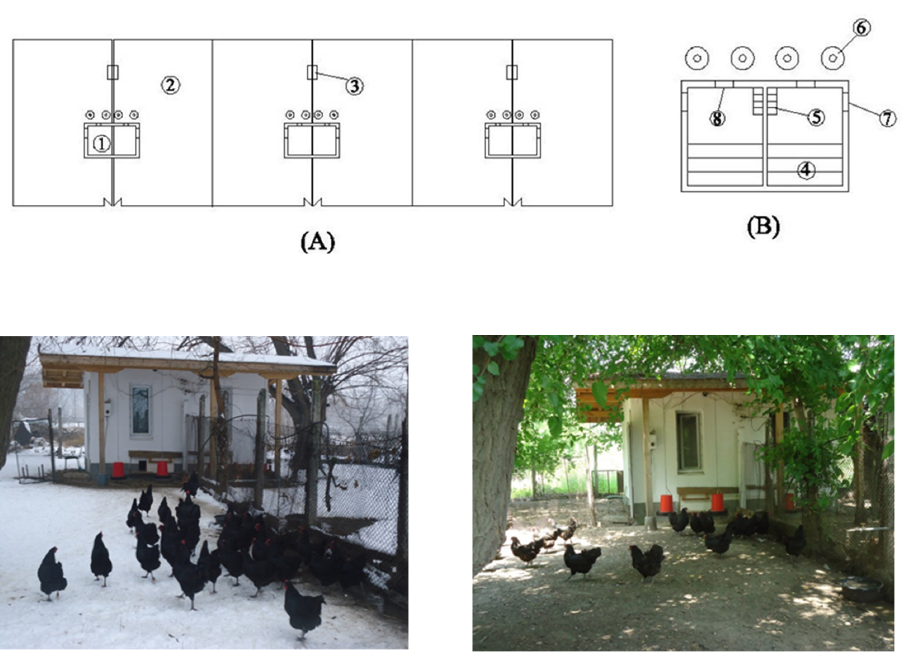
Figure 1. Schematic drawing and photo of the poultry farm: ( A )—pen ① , fenced yard ② , water drinker ③ ; pen ( B )—perches ④ , nests ⑤ , plastic feeders ⑥ , door ⑦ , pop-holes ⑧ . Compound feed (mash form) and water were offered for consumption ad libitum . The diets were with equal feed and nutrient composition for all groups and were consistent with the laying phase—Table 1. Table 1. Ingredients and nutrient composition of the